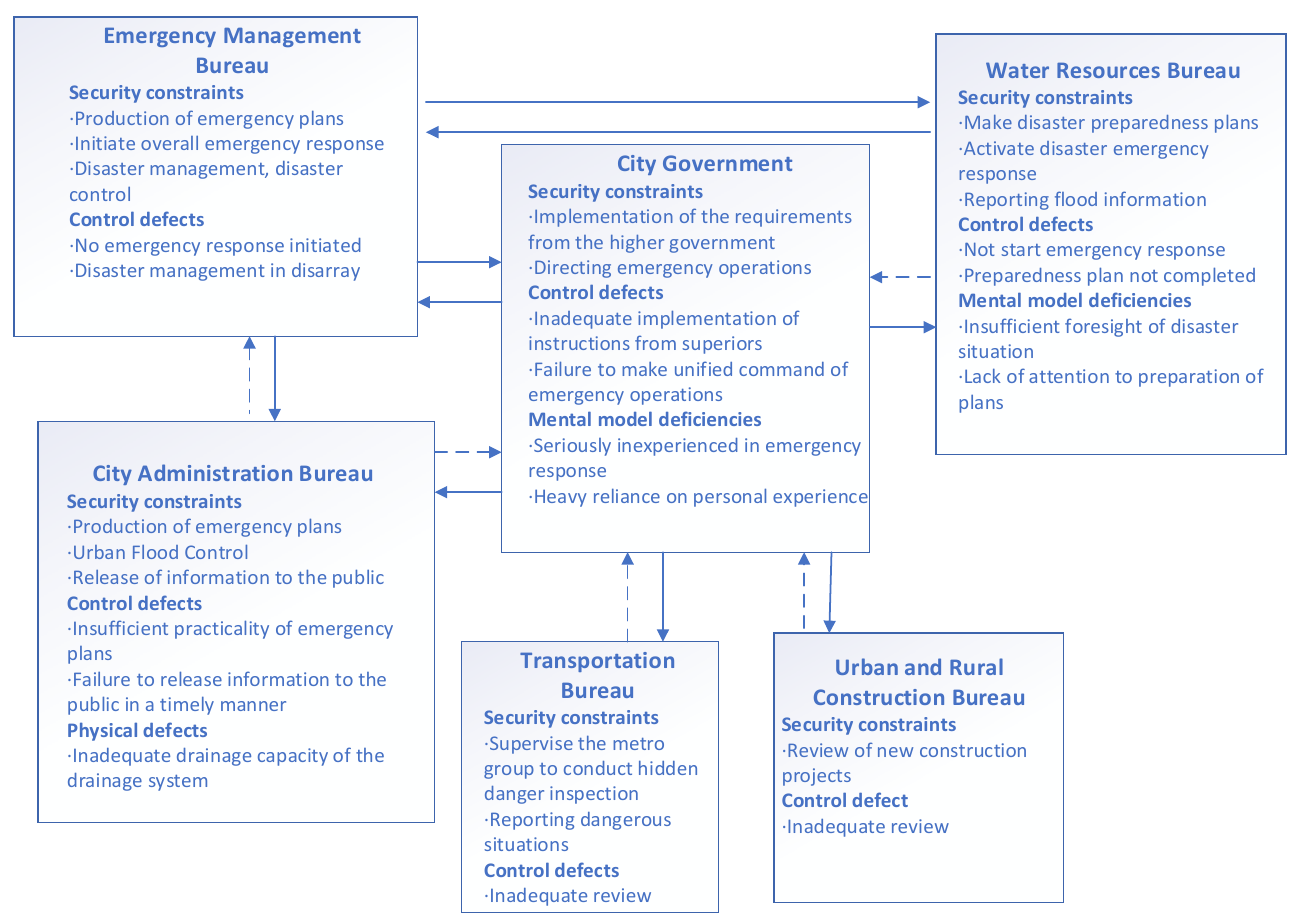
Figure 5. CAST analysis of the Zhengzhou government’s emergency control structure.